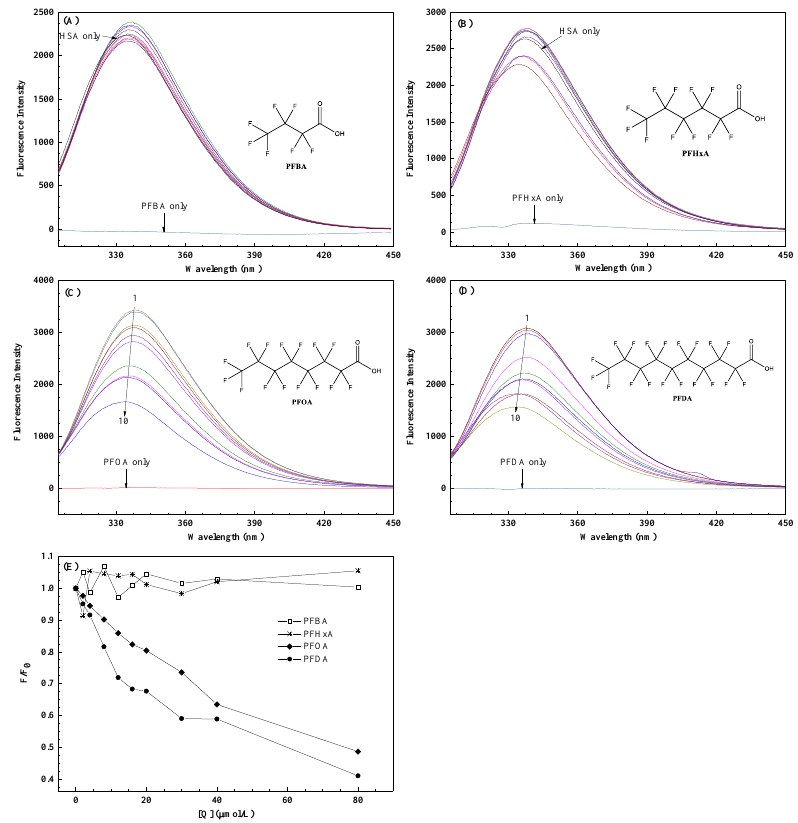
Figure 1. The fluorescence quenching spectra of human serum albumin (HSA) by perfluorobutanoic acid (PFBA) ( A ), perfluorohexanoic acid (PFHxA) ( B ), perfluorooctanoic acid (PFOA) ( C ) and perfluorodecanoic acid (PFDA) ( D ) at 296 K, λ ex = 295 nm; the inset corresponds to the molecular structure of PFCAs; ( E ) Normalized fluorescence intensity of HSA with different PFCA concentrations. [PFCAs] (×10 –6 mol/L) 1–10: 0, 2, 4, 8, 12, 16, 20, 30, 40 and 80. [HSA] = 2 × 10 –6 mol/L; Buffer: PBS, pH = 7.4.